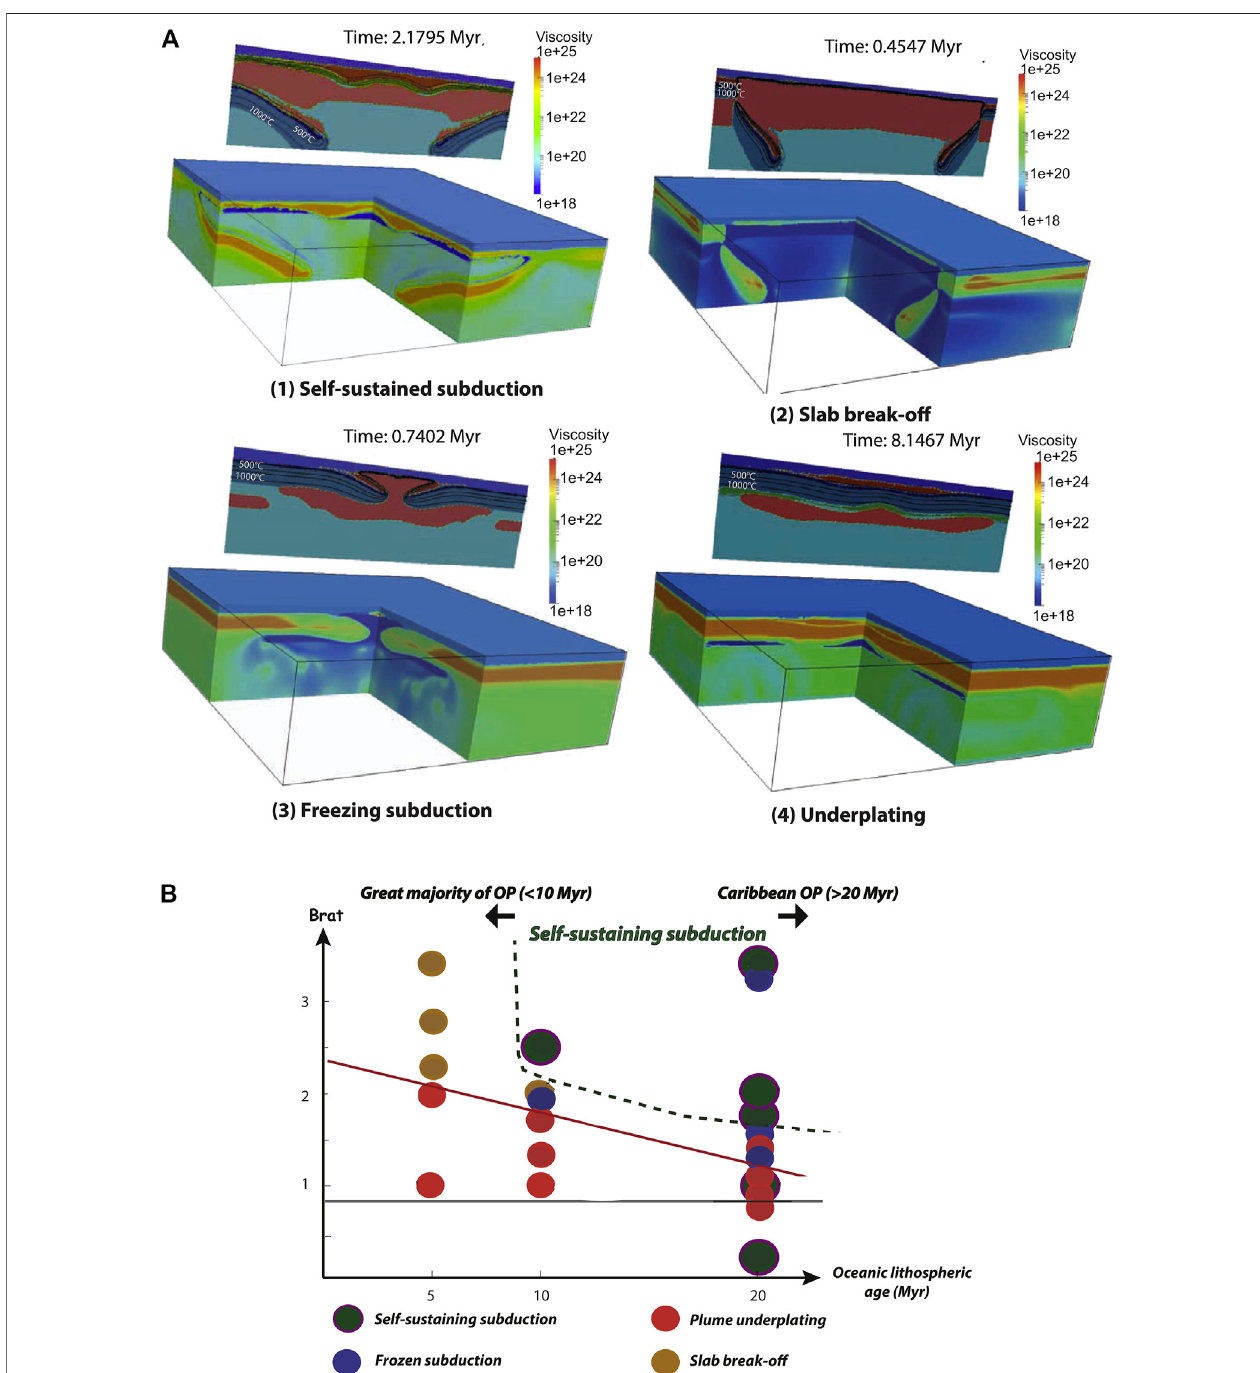
FIGURE 7 | (A) Four different deformation regimes resulting from plume-lithosphere interaction based on numerical models of Baes et al. (2016). The 2D cross- sections show the evolution of the lithological structure (color codes are shown in the right side of fi gure). Black lines show isotherms of 200 ° C, 500 ° C, 700 ° C, and 1,000 ° C. The 3D panels show the evolution of the viscosity structure. (B) Dependence of four different responses to plume – lithosphere interaction on oceanic lithospheric age (horizontal axis) and Brat number (i.e., the non-dimensional ratio of plume buoyancy and lithospheric strength, vertical axis). Each circle illustrates the result of one of the experiments. Different colors represent different responses to plume – lithosphere interaction. Gray and red lines show optimum values of the Brat number for a plume to penetrate through the lithosphere, based on the results of Ueda et al. (2008) and Baes et al. (2016), respectively. OP stands for oceanic plateau. The green dashed curve shows the domain with a high probability of self-sustaining subduction initiation. The large black arrows on top of the fi gure indicate that most oceanic plateaus form on lithosphere younger than 10 Myr. In contrast, the Caribbean plateau is among the few oceanic plateaus that formed on older than 20 Myr lithosphere (obtained from Baes et al., 2016).